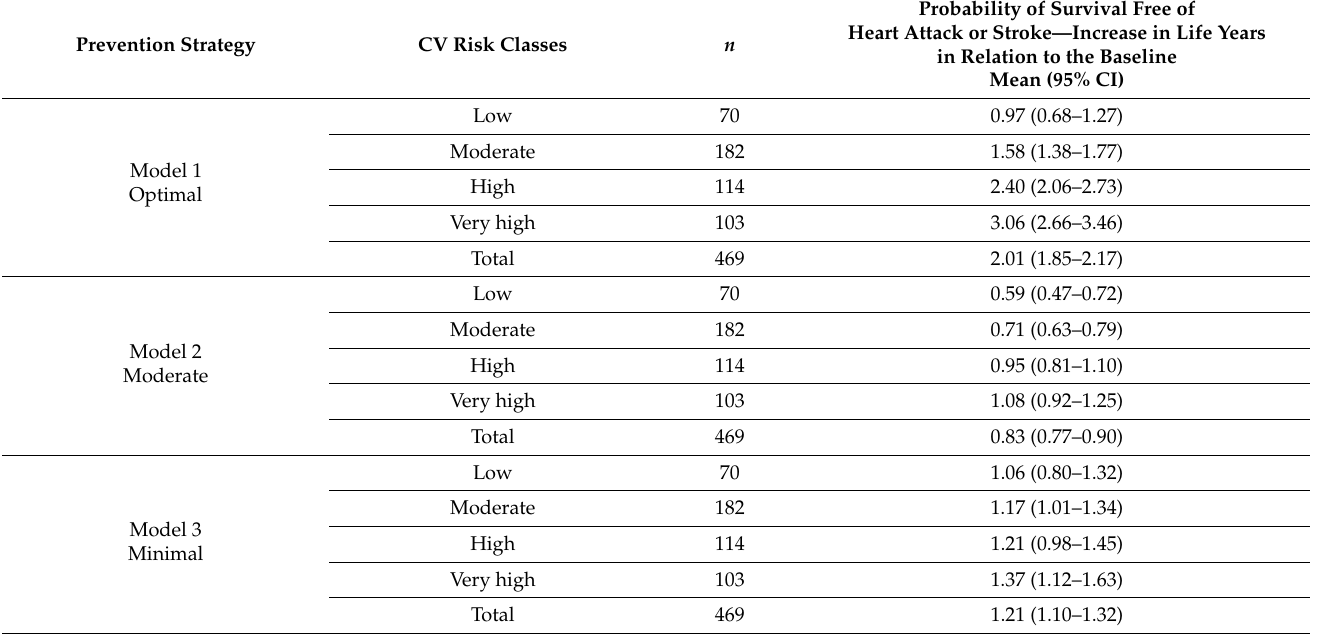
The data are shown as means and 95% confidence intervals (95% CI). MI, myocardial infarction; CV, car- diovascular; BPs, systolic blood pressure; TC, total cholesterol; LDL-C, low-density lipoprotein cholesterol. Model 1: optimal prevention strategy: BPs < 130 mmHg, LDL-C in low CV risk class < 116 mg/dL, in mod- erate CV risk class < 100 mg/dL, in high CV risk class < 70 mg/dL, in very high CV risk class < 55 mg/dL,